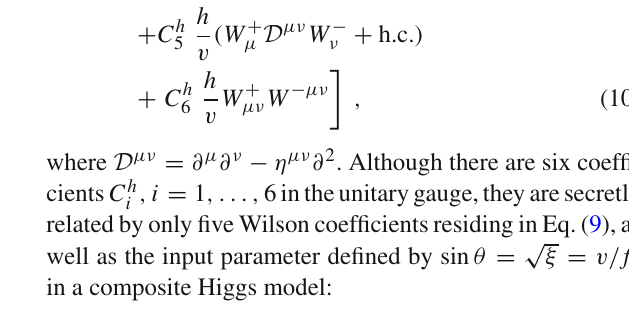
Fig. 1 Typical spectrum of composite Higgs models. The nl σ m Lagrangian is valid below Λ ∼ 4 π f , which is the highest cutoff in the model. Below the composite resonances the SILH effective Lagrangian is valid, although with identical nonlinear structure to the nl σ m Lagrangian, assuming a sufficient mass gap between M ρ and